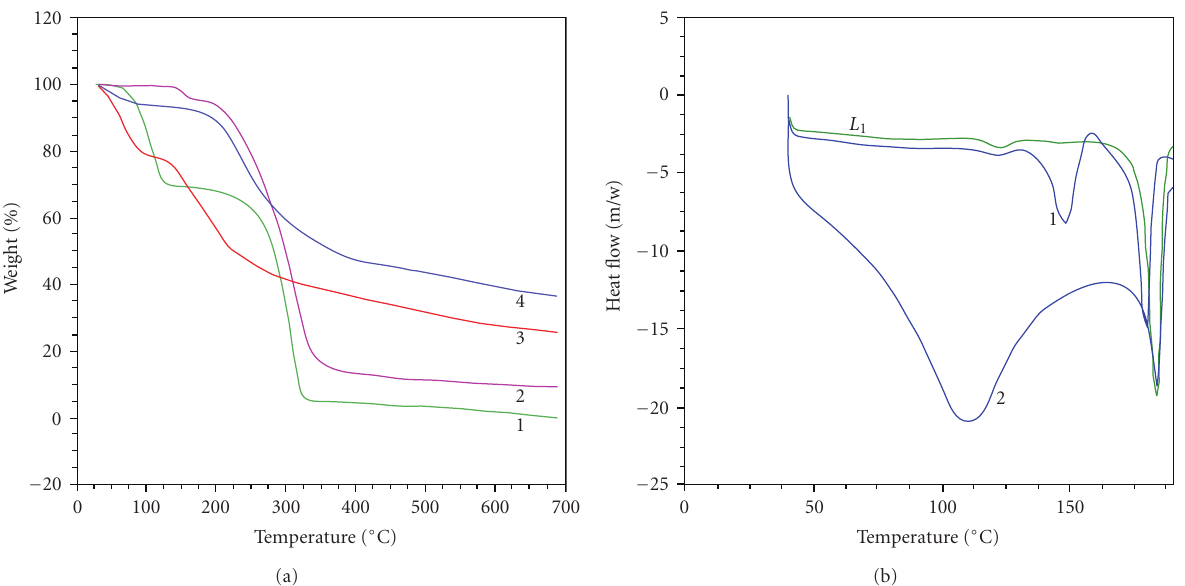
Scheme 1: Synthetic route of the ligands.